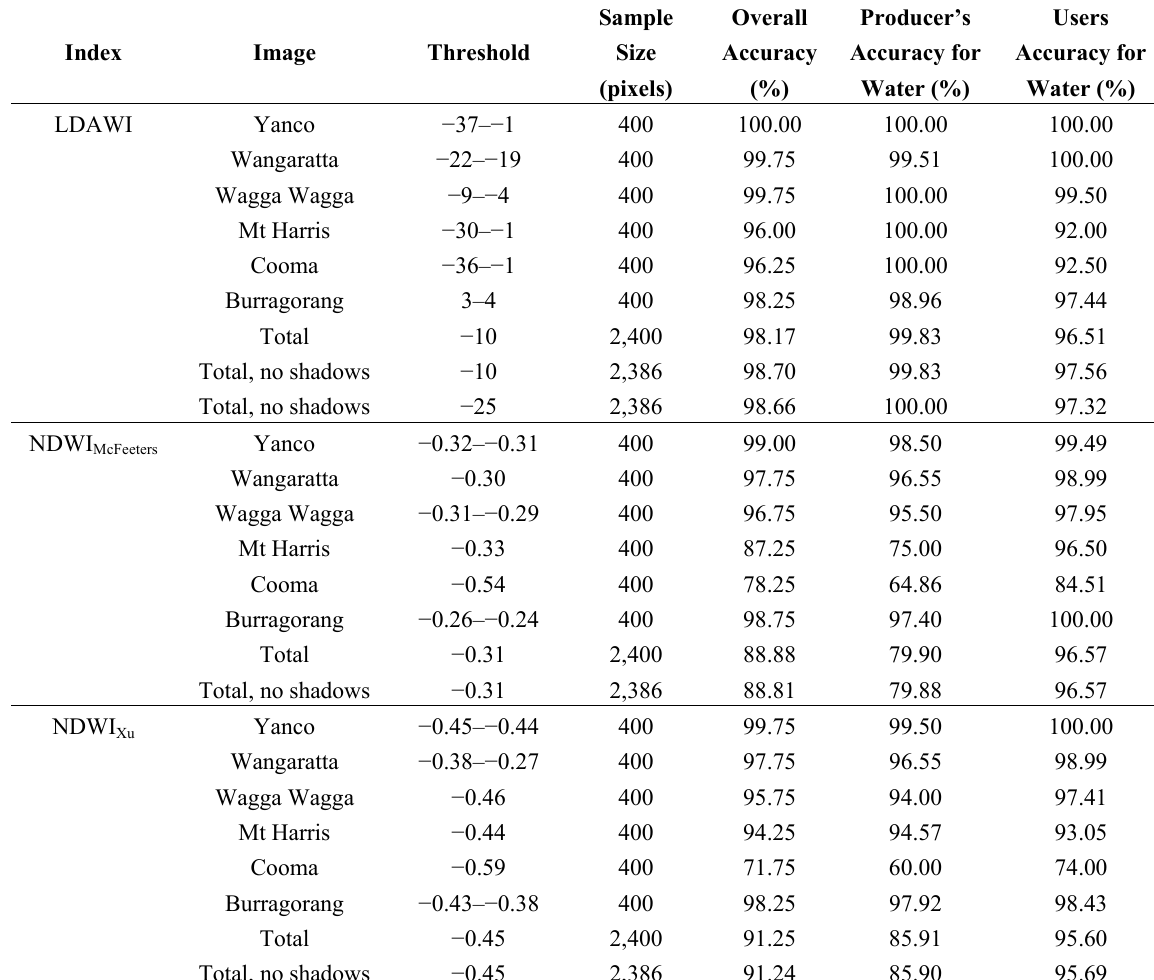
Table 3. Accuracy statistics for water classifications based on the linear discriminant analysis water index (LDAWI) and the normalized difference water index of McFeeters (NDWI ) and Xu (NDWI ). Statistics were calculated using sample points that McFeeters Xu were manually classified through high resolution Airborne Digital Sensor (ADS40) image interpretation. Thresholds were determined as the value that firstly gave the greatest overall accuracy, and secondly gave the greatest producer’s accuracy. Where a range of threshold values had the same accuracy, the upper and lower values are both shown. LDAWI thresholds were varied by single units, while NDWI thresholds were varied by hundredths of a